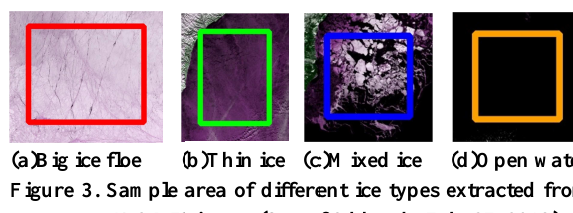
Figure Figure 3 . Sample area MODIS image Thin Ice Algorithm Thin Ice 4.2 Figure 19GHz (V 2013. In this scatter plot, represents